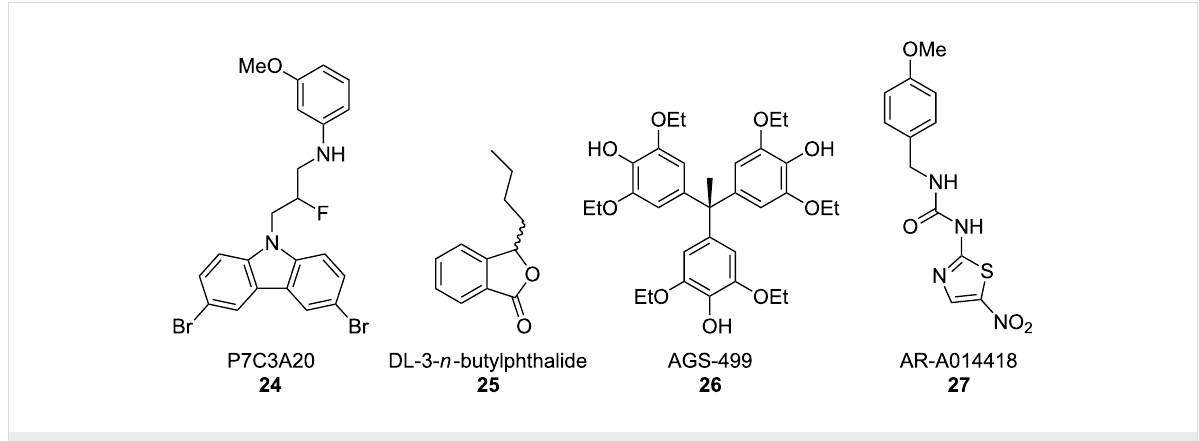
Figure 12: Compounds identified as